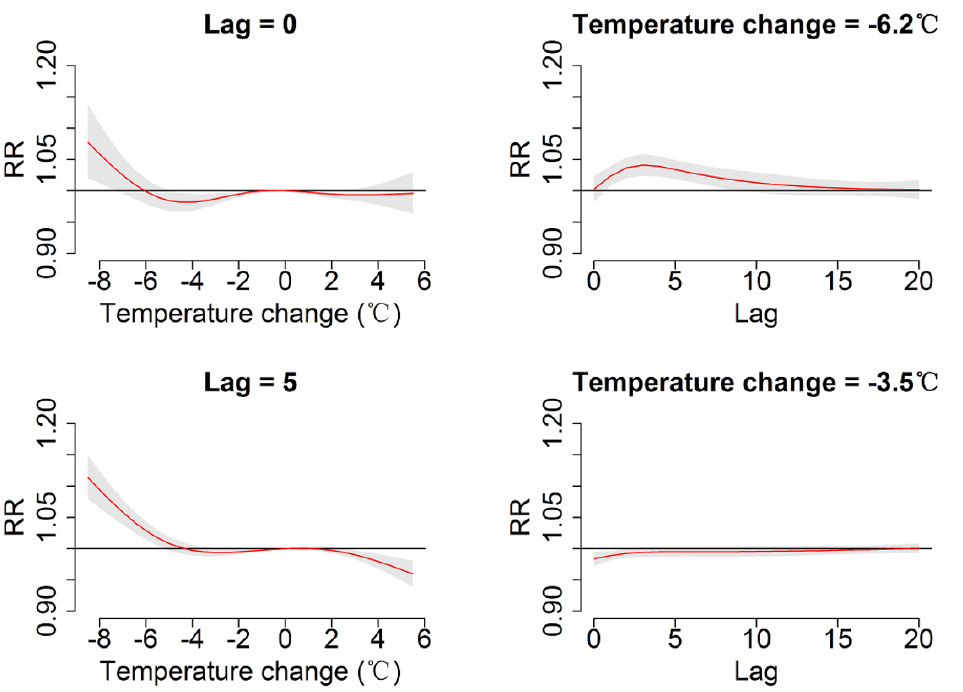
Figure 2. Relative risks of an outpatient visit for a respiratory tract infection (RTI) by temperature change (°C) and days of lag, with reference at 0 °C temperature